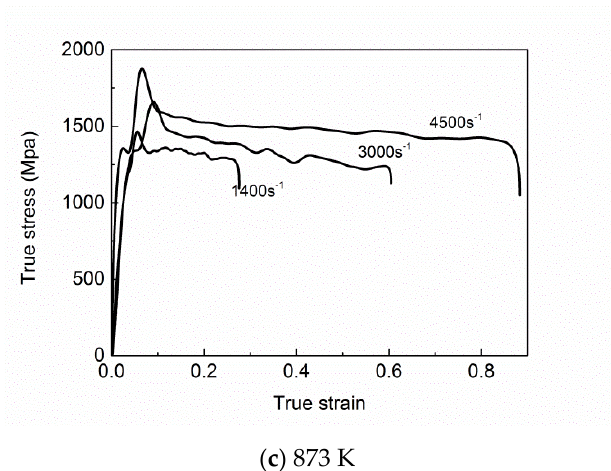
Figure 7. The dynamic/static compression stress-strain relationship of Mo-10Ta alloy at different ambient temperature, ( a ) T = 286 K, ( b ) T = 473 K, ( c ) T = 873 K.